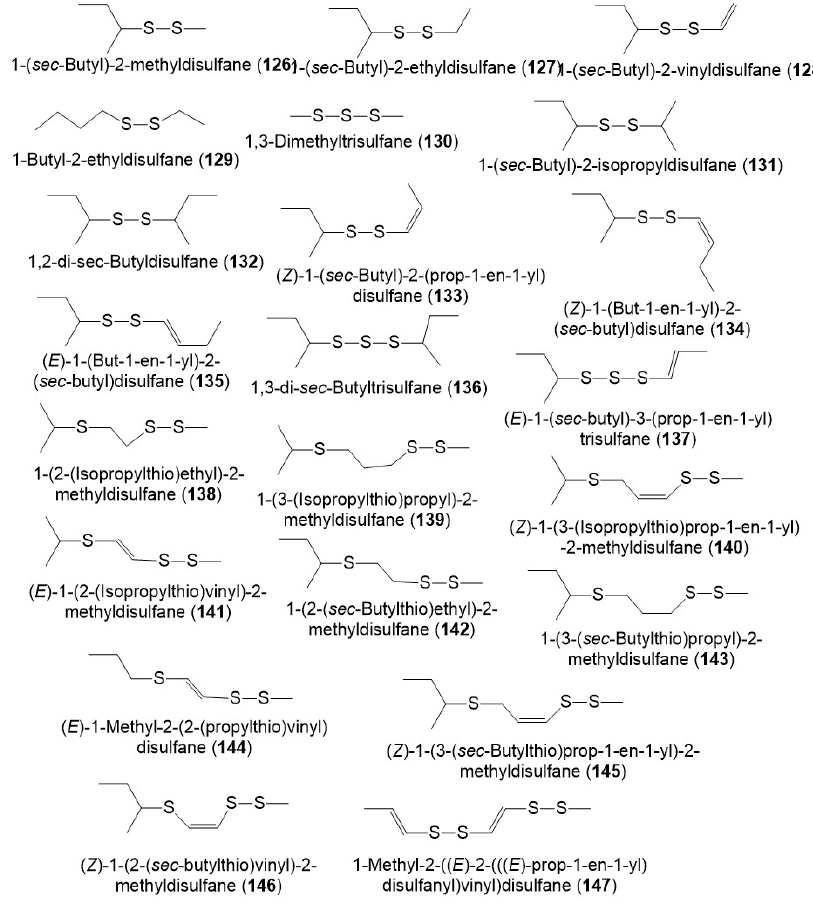
Figure 16. Structures of sulfanes ( 126 – 147 ) reported from F. sinkiangensis .